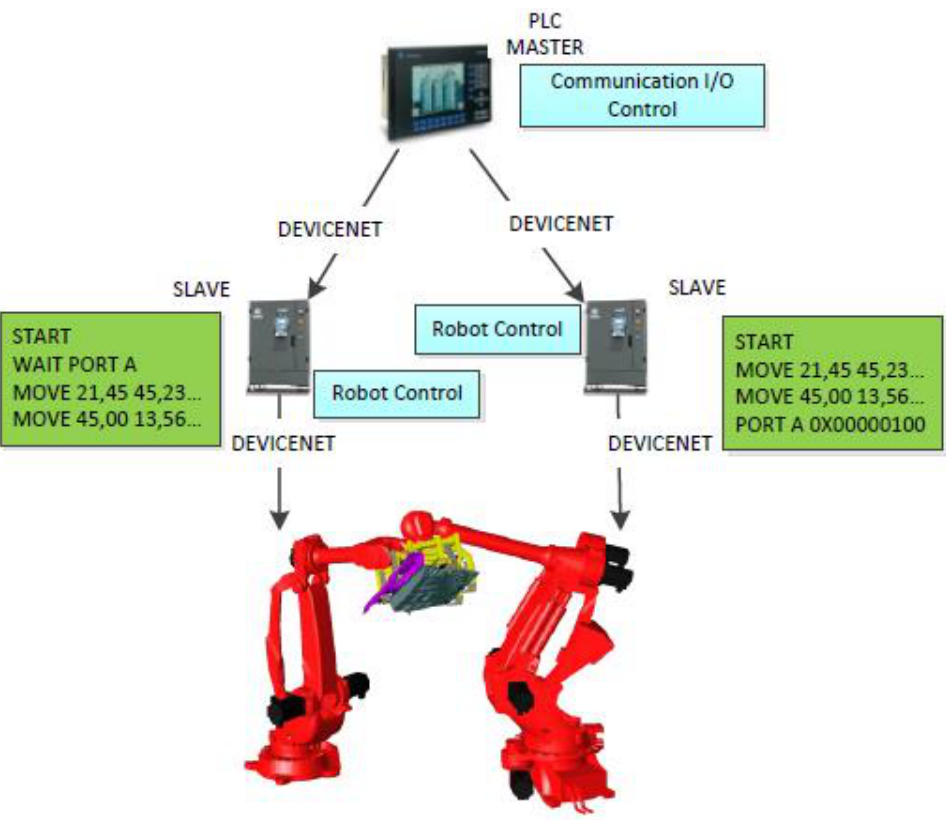
Figure 11. Programmable Logic Controller (PLC) approach for robot synchronization.